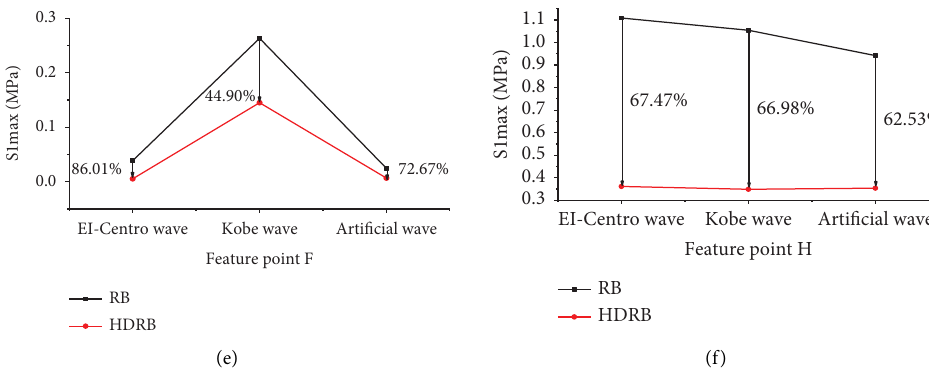
Figure 11: Maximum seismic responses of aqueduct structure under diferent seismic wave excitation. (a) Transverse deformation of the aqueduct structure. (b) Maximum of the frst principal stress at point A. (c) Maximum of the frst principal stress at point B. (d) Maximum of the frst principal stress at point E. (e) Maximum of the frst principal stress at point F. (f) Maximum of the frst principal stress at point